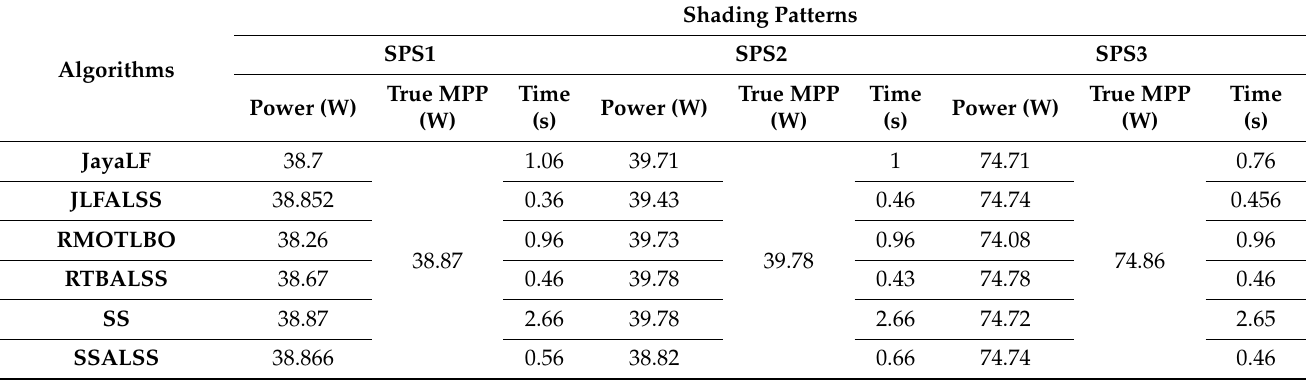
Table 2. The static PS scenario performance